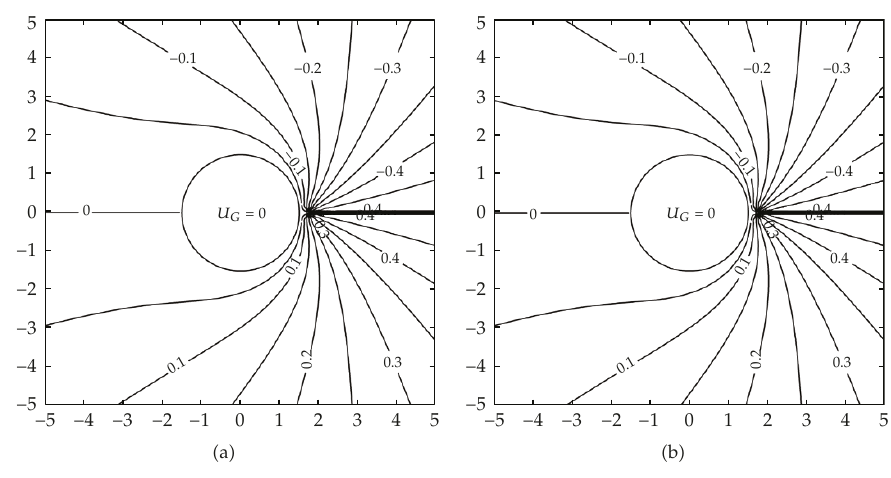
Figure 7: Displacement contour (cid:5) Dirichlet boundary condition (cid:6) by using (cid:5) a (cid:6) the Smith’s method (cid:2) 1 (cid:3) and (cid:5) b (cid:6) the present method (cid:5) M (cid:4) 50 (cid:6) .